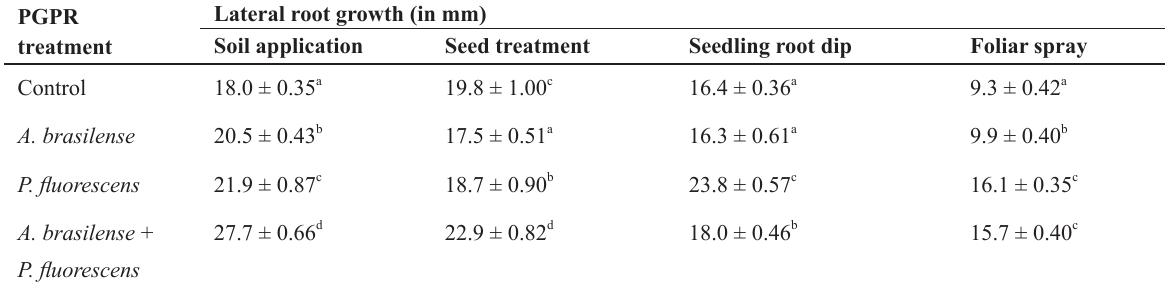
Effect of methods of application of single and mixed PGPR on the lateral root growth of groundnut plants.